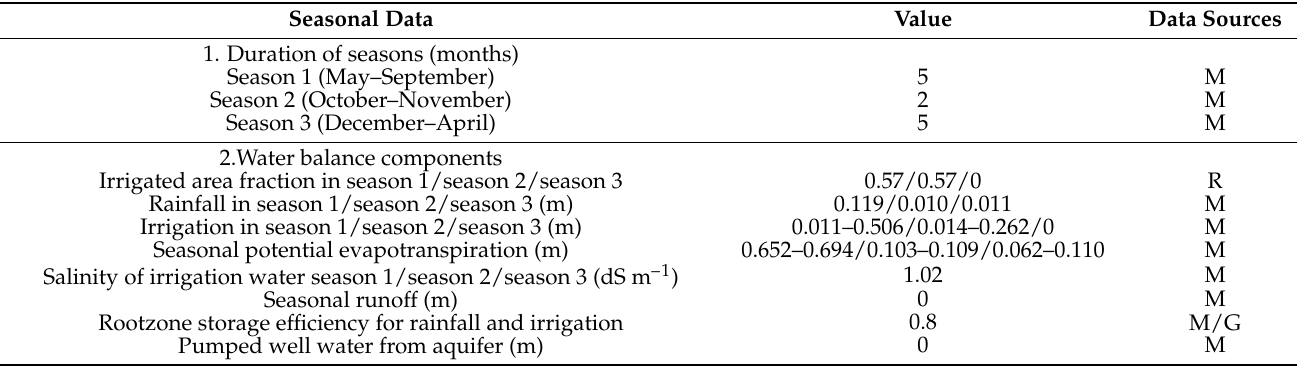
Table 1. Seasonal input data of SAHYSMOD model.